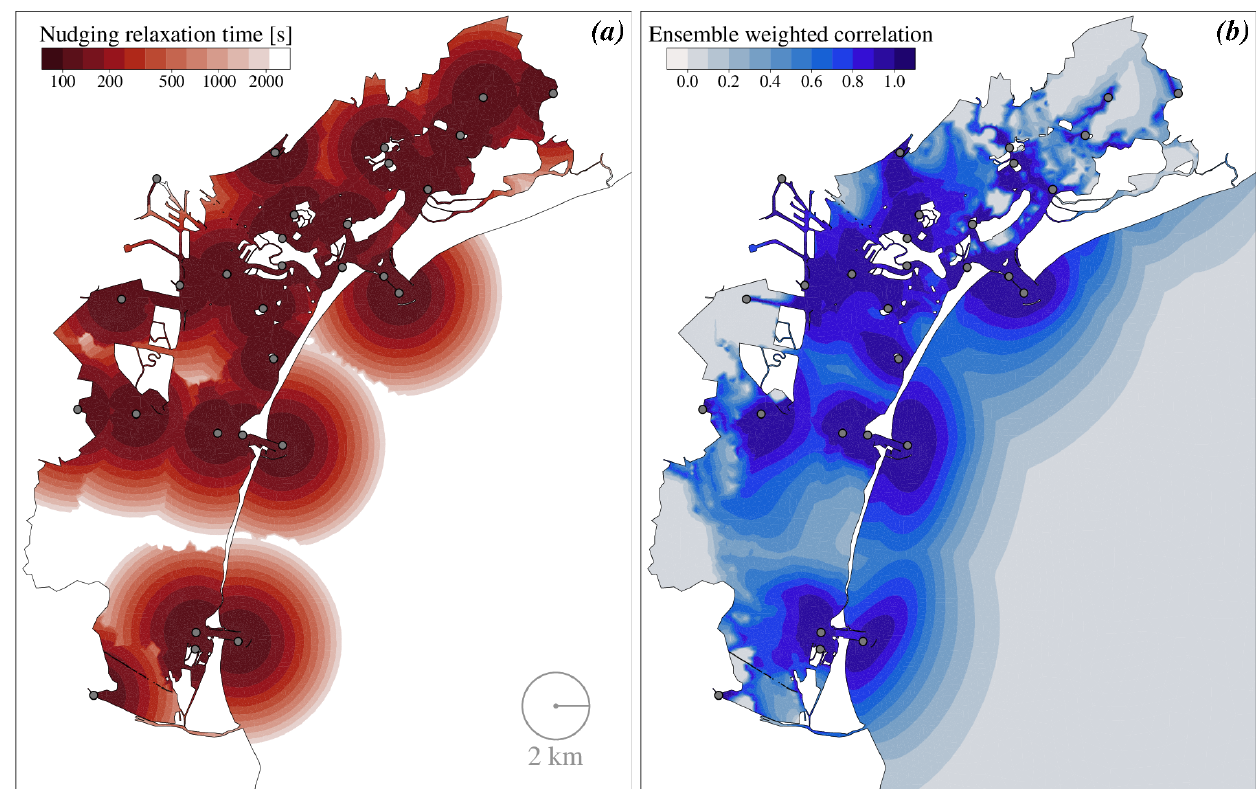
Figure 2. Spatial distribution of (a) the relaxation time adopted in the nudging and (b) the weighted correlation of the ensemble considered in the EnSRF